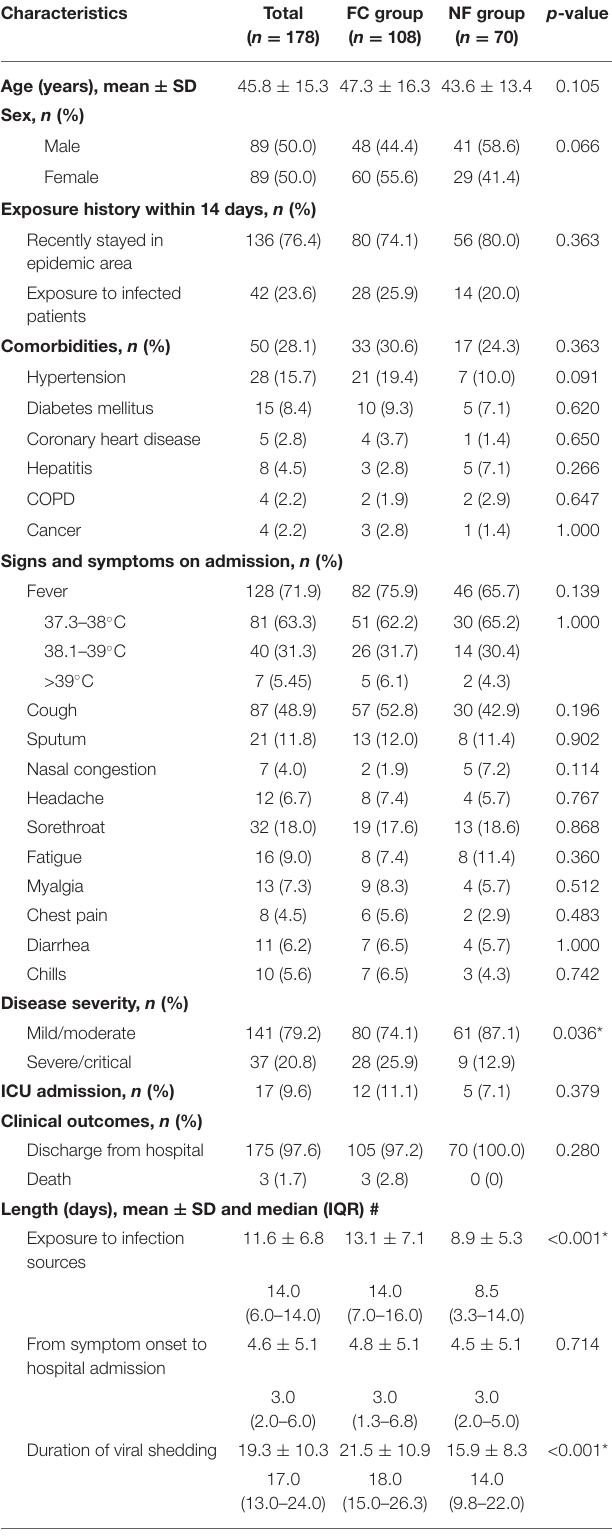
TABLE 1 | Demographics and clinical characteristics of patients with COVID-19 pneumonia between FC and NF groups.